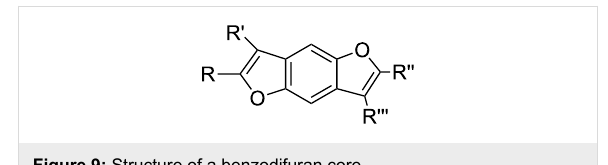
Figure 9: Structure of a benzodifuran